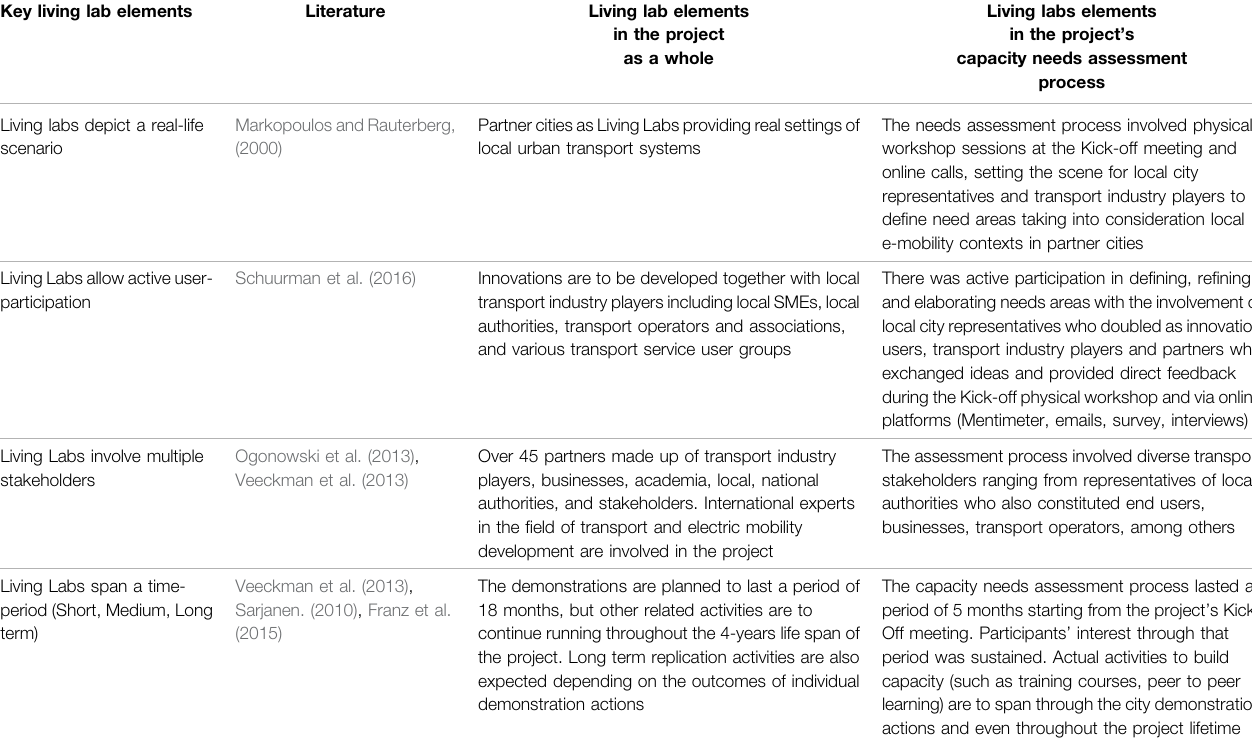
TABLE 3 | Summary of key elements of Living Labs in the project and in its Capacity Needs Assessment process. Key living lab